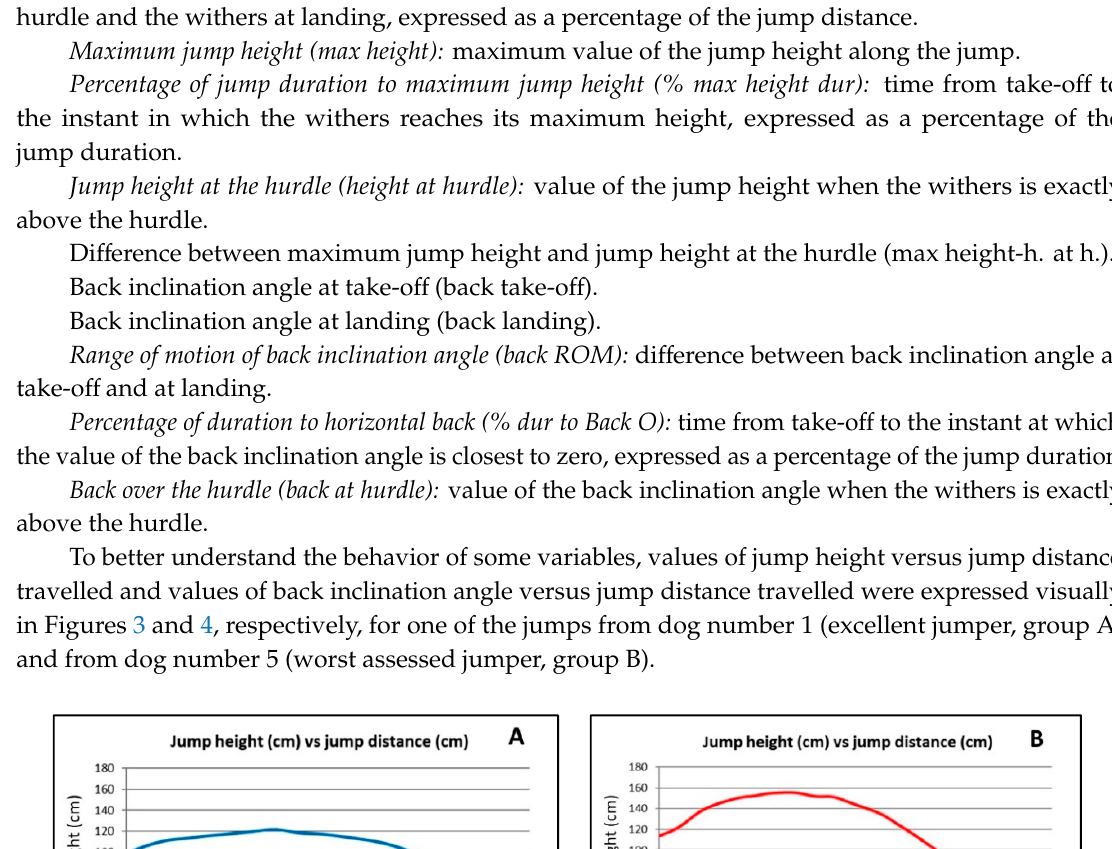
Figure 4. Graphic representation of the back inclination angle (°, x- axis ) vs. jump distance travelled (cm y- axis) of two agility dogs jumping over a 60-cm high hurdle. ( A ) dog number 1 in group A (excellent jumpers, competing in third and greater level of competition). ( B ) dog number 5, ranked as the worst jumper among all the dogs of group B (less-skilled jumper, competing in second and lower level of competition). Vertical line represents the position of the hurdle in relation to the distance travelled.